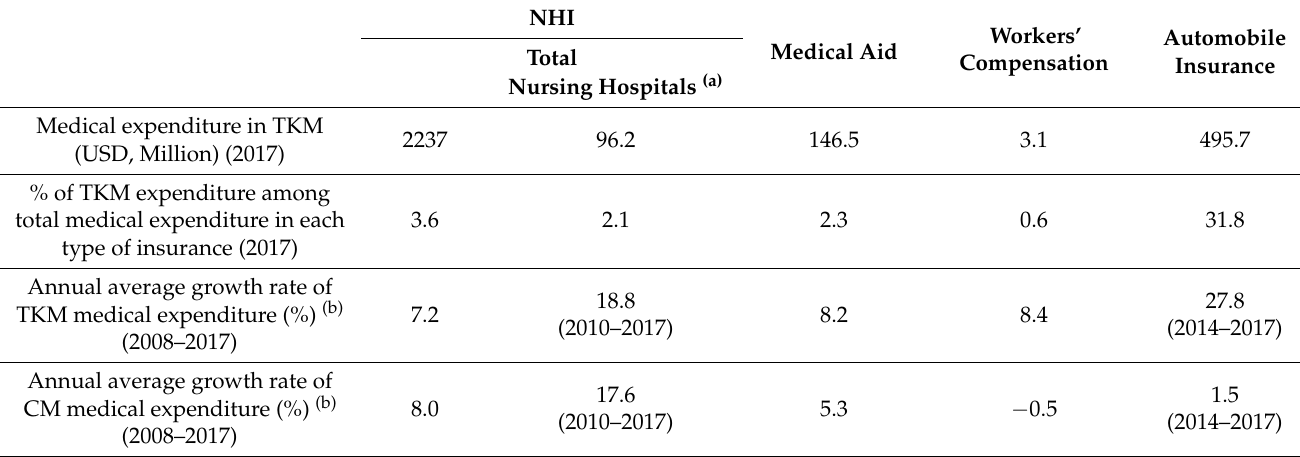
Table 2. Medical expenditure in Traditional Korean Medicine by the type of health insurance in